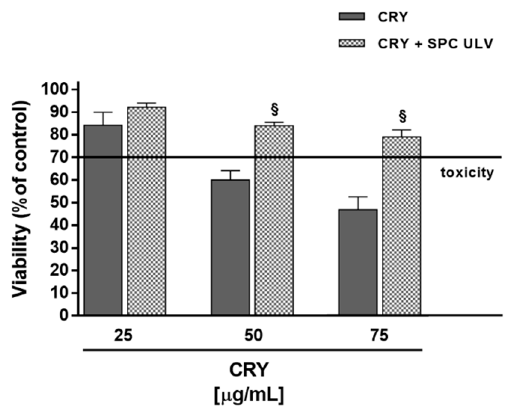
Figure 8. Cytotoxicity of CRY and the combination of SPC/CRY ULV (1:0.5 mol/mol) in HepG2 cells after 24 h incubation. § p < 0.001 vs. CRY, denotes a statistically significant reduction respect to CRY cytotoxicity (ANOVA + multiple Dunnett’s comparison post-test). A cell viability lower than 70% respect to control (i.e., vehicle-treated cells) was considered as cytotoxic [26].